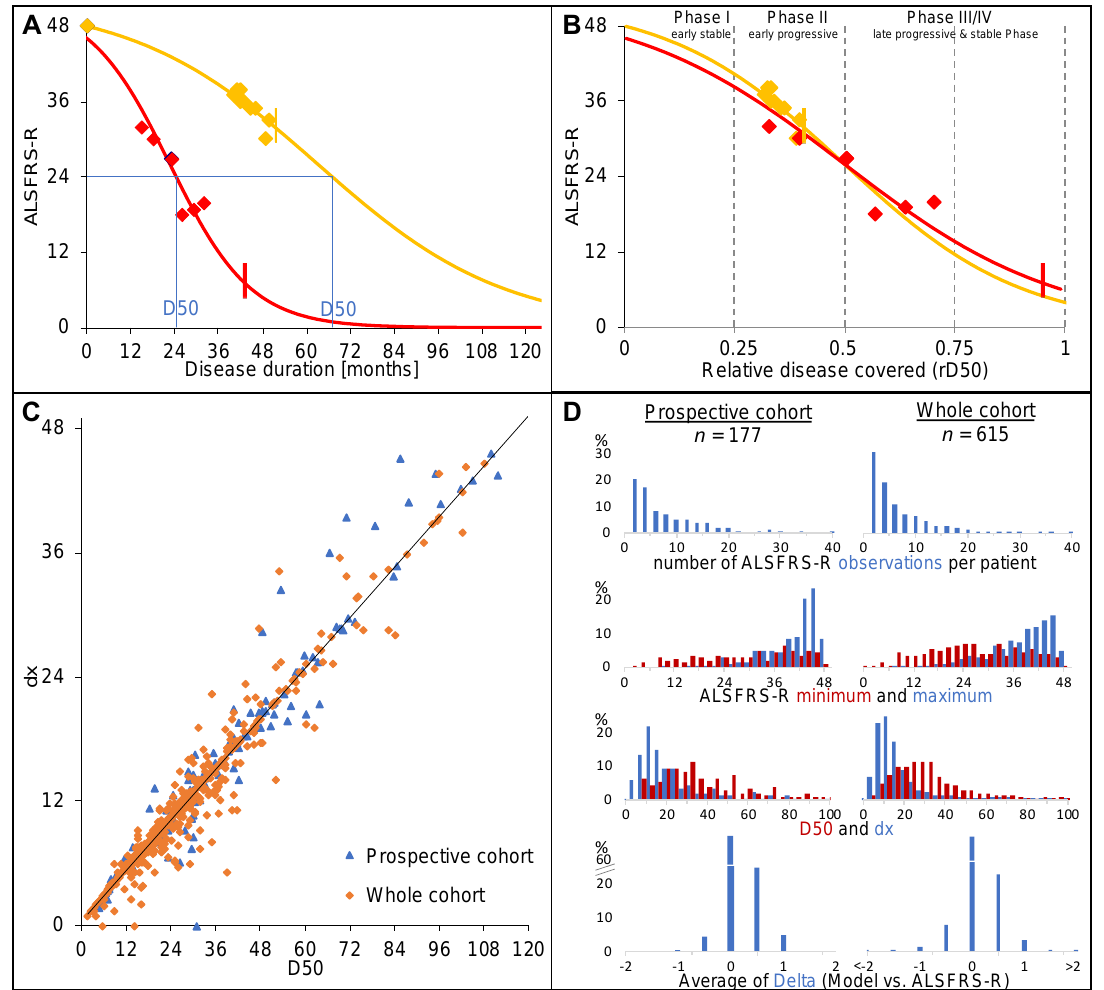
Figure 2. D50 disease progression model. ( A ) Patient with high (depicted in red, D50 = 22.8 months) and another with lower disease aggressiveness (depicted in yellow, D50 = 63.3 months). The individual disease curve is modelled based on all available ALSFRS-R scores (squares). The vertical lines mark the acute position in the disease course at March 2020. ( B) Normalization with rD50, which describes individual disease course covered in reference to D50, allows for comparability between patients who all proceed through similar Phases (I-IV) of functional decline, despite vastly di ff ering disease aggressiveness. ( C ) D50 and dx (time constant of ALSFRS-R total score decline) correlate linearly in all 651 patients who were available in the database and the prospective cohort respectively. ( D ) Modelling data for the prospective cohort (left column) and for all ALS patient data available at our neuromuscular center. From top to bottom, the number of obtained ALSFRS-R scores per patient, the minimum ALSFRS-R score (red), the maximum ALSFRS-R score (blue), and the calculated D50 (red) and dx (blue) values, and the o ff set between model data and scores do not di ff er between the cohorts.